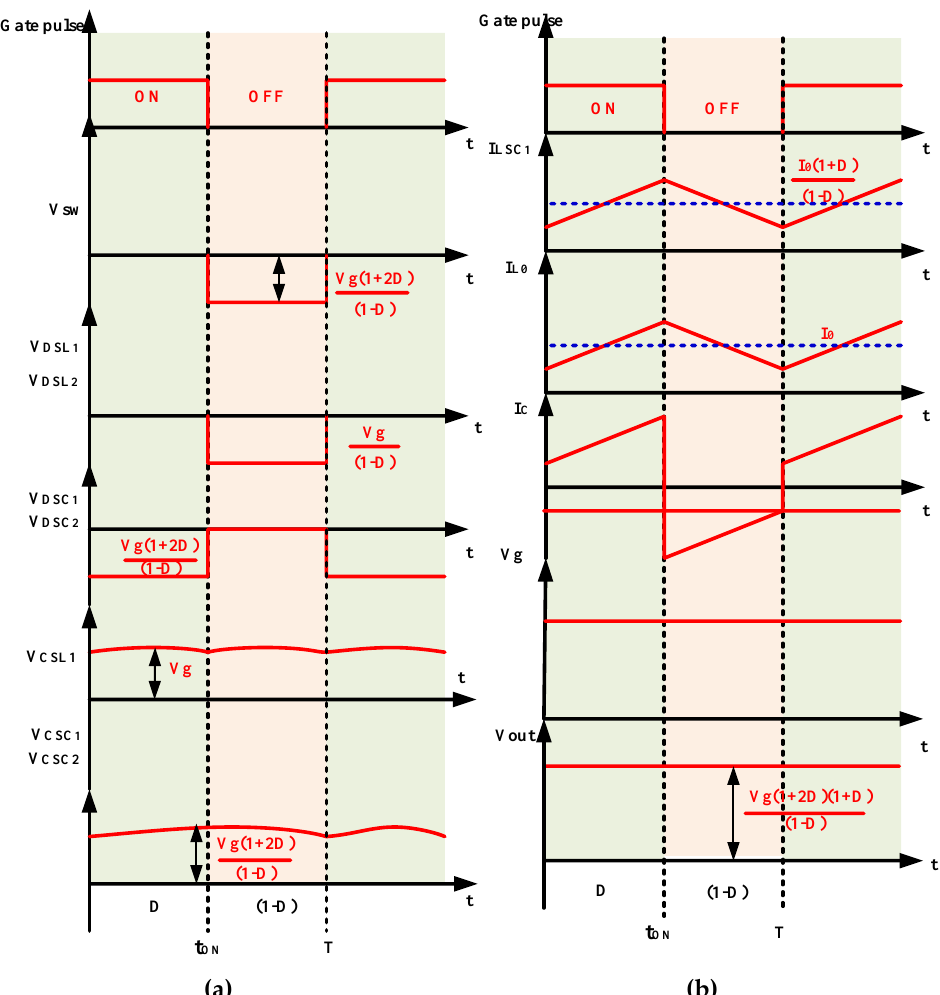
Figure 6. The proposed PSLSC converter waveforms ( a ) voltage waveforms; ( b ) current waveforms along input and output voltage waveforms.